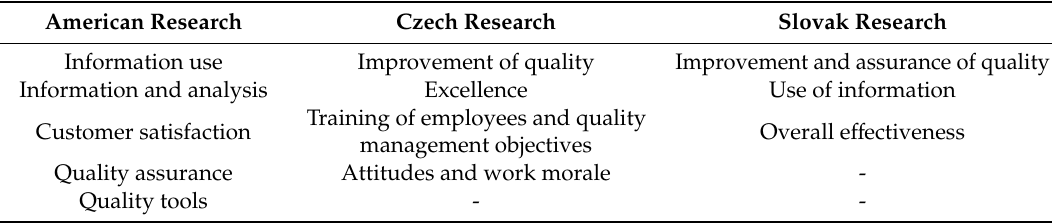
Table 19. Comparison of significant variables.